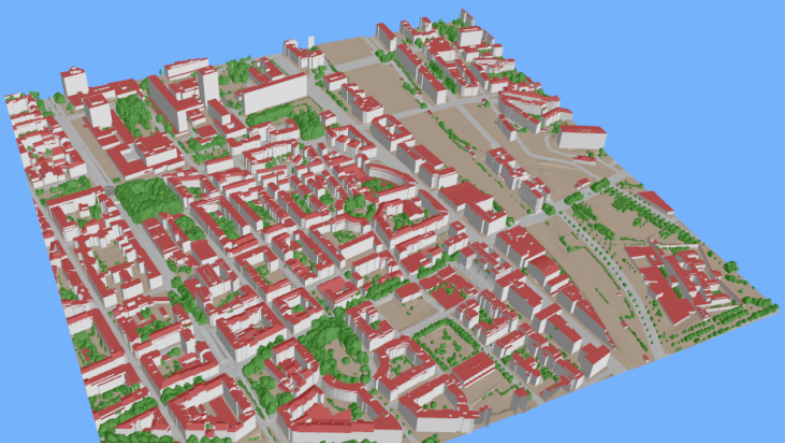
Figure 6. A 1 × 1 km tile of Lyon composed of four types of objects: buildings, terrain, roads and